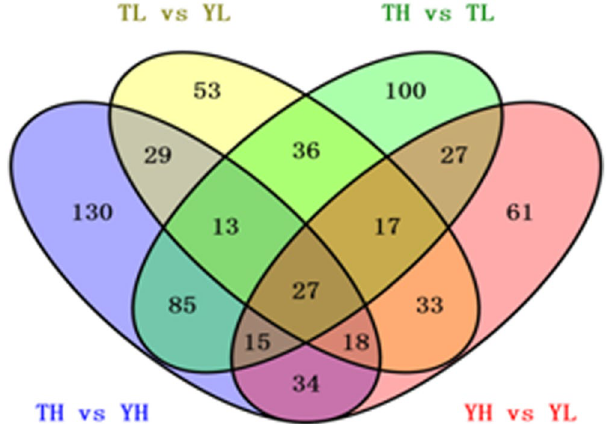
Figure 1. Venn diagram of differentially expressed genes (DEGs) among the four comparison groups. TH, Tibetan highland pig; TL, Tibetan lowland pig; YH, Yorkshire highland pig; YL, Yorkshire lowland pig.